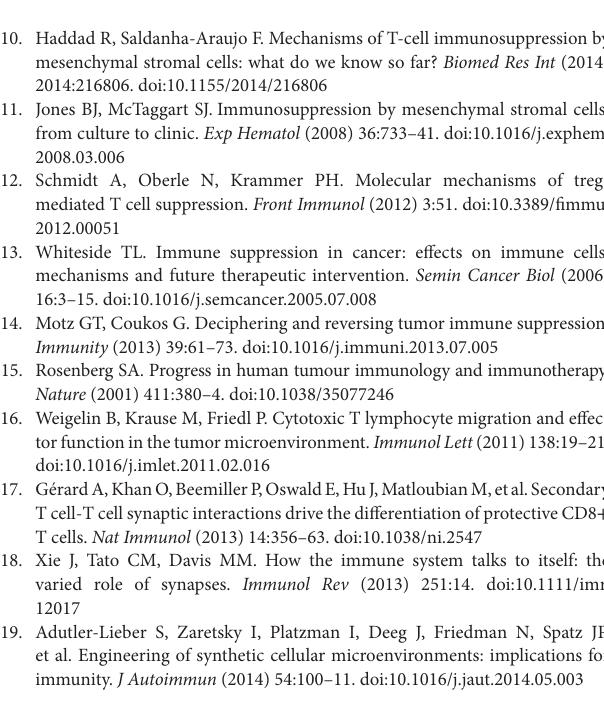
co-cultured with T-cells pre-cultured for 7 days, quantified using automated image analysis. Data are representative of at least three independent experiments with 10 replicates each. Error bars represent SEM. Calculated p -values (standard t -test) are as indicated in the Figure. CCL21 + ICAM1 augment the killing of target cells by T-cells pre-cultured for 7 days, while addition of soluble IL-6 to the substrate-immobilized CCL21 + ICAM1 attenuates it. FigUre s4 | Substrate-immobilized CCL21 + intercellular adhesion molecule 1 (ICAM1) increase T-cell expression of Granzyme B and PD-1, while not affecting FasL. Fold change in the mean fluorescence intensity of Granzyme B, FasL, and PD-1. The mean fluorescence intensity in cells cultured on CCL21 + ICAM1- coated substrates, measured at the experimental end point, was normalized to that obtained on uncoated substrates. Each symbol denotes the average fluorescent intensity of the CCL21 + ICAM1group normalized to that of the uncoated group in one independent experiment: average of four replicates that were performed at the same date and with the same conditions (same initial cell number, incubation time and format, and cell enumeration method). Error bars represent SEM. ViDeO s1 | Culturing OT-I CD8 + cytotoxic T-cells for 7 days on substrate- immobilized CCL21 + intercellular adhesion molecule 1 (ICAM1) reduces the killing time of ovalbumin-expressing B16 cells, while addition of soluble IL-6 to the culture increases it. CD8 + T-cells (unstained), were pre-cultured for 7 days prior to co-culturing, on either uncoated substrates (a,B) , or on substrate- immobilized CCL21 + ICAM1 (c,D) , with (D) or without (c) the addition of soluble IL-6. T-cells were then co-cultured with either B16-GFP cells (a) or B16- ovalbumin-GFP cells (B–D) , live cells shown in green. The killing of live (e.g., GFP-expressing) B16 cells is noticeable when the dead cells stop expressing the GFP color, and turn from green-colored to non-colored as they detach from the substrate. OT-I cytotoxic T-cells pre-cultured on substrate- immobilized CCL21 + ICAM1 (B) killed ovalbumin-expressing B16 significantly faster than those cultured on an uncoated substrate (a) , as demonstrated by the earlier disappearance of green cells (see quantification in Figure 4 ). However, OT-I cytotoxic T-cells pre-cultured with the addition of soluble IL-6 on top of the substrate-immobilized CCL21 + ICAM1, demonstrated a much slower rate of killing of B16 target cells (c) than those cultured on an uncoated substrate (a) . No cell killing was evident when OT-I T-cells were co-cultured with B16-GFP cells, which did not express the ovalbumin peptide (D) . Time stamp, hh:mm:ss. Scale bar: 50